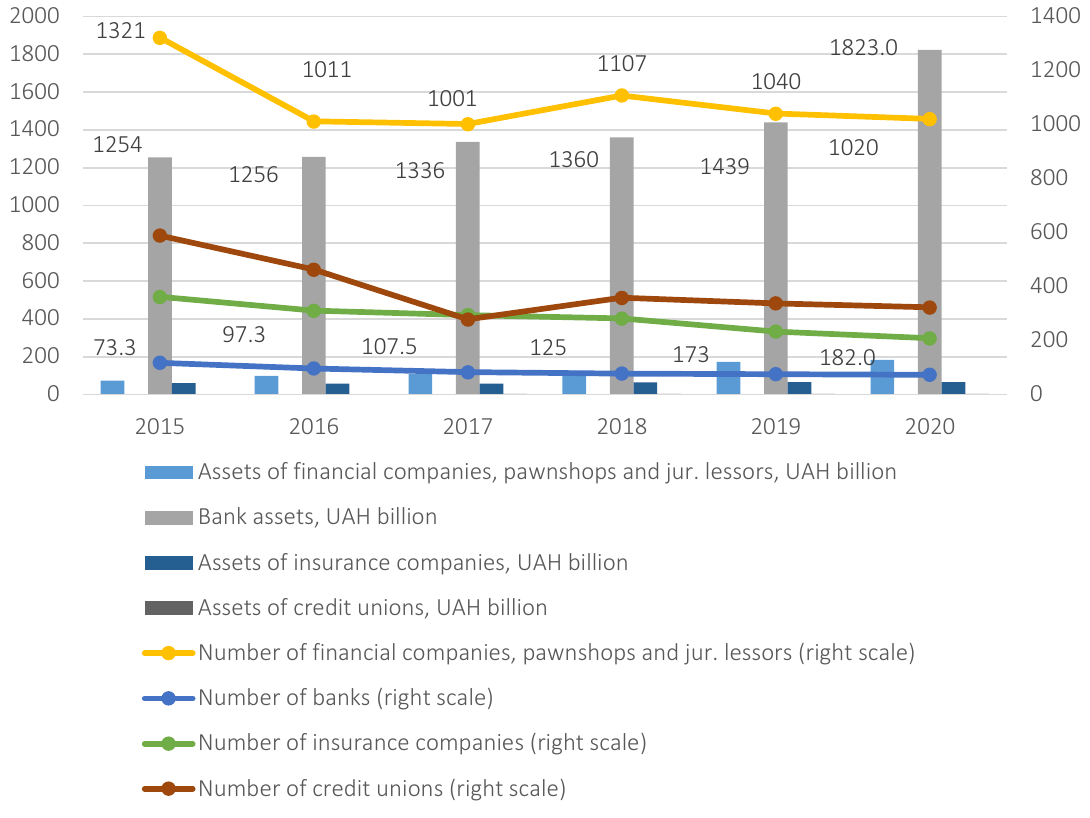
Figure 2. Number of non-bank financial institutions and banks in Ukraine in